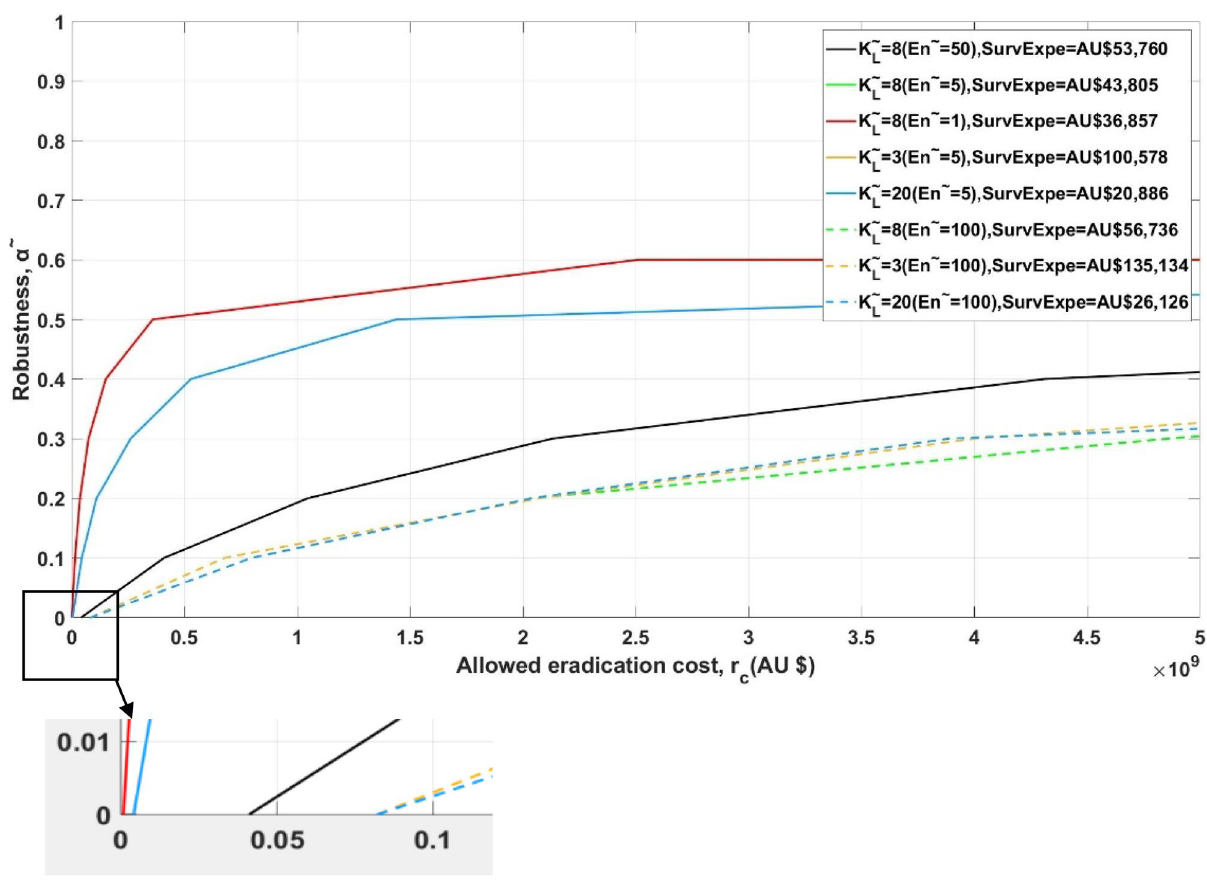
Figure 3. Robustness curves using the spatial dispersal model. ˜ K L is the estimated population threshold for detection, assumed to be the same at each location L = 1, . . . , 6 and ˜ En is the estimated annual number of entries of Asian house gecko after border inspection to any of the locations on Barrow Island. The corresponding optimal surveillance cost in each situation are listed as ‘SurvExpe’ in the legend. The lines with the same value of ˜ En are aligned with each